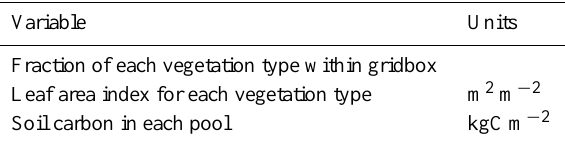
Table 1. State (prognostic) variables for vegetation and soil carbon. If vegetation competition is disabled, the fraction of vegetation is prescribed and does not vary with